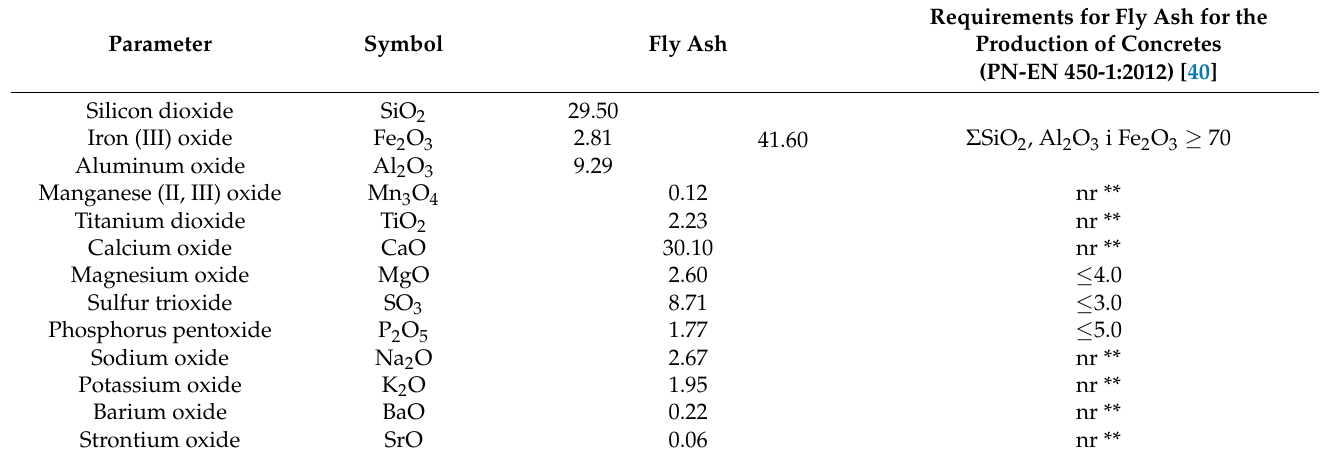
Table 1. Contents of oxides (%) in the tested fly ash.